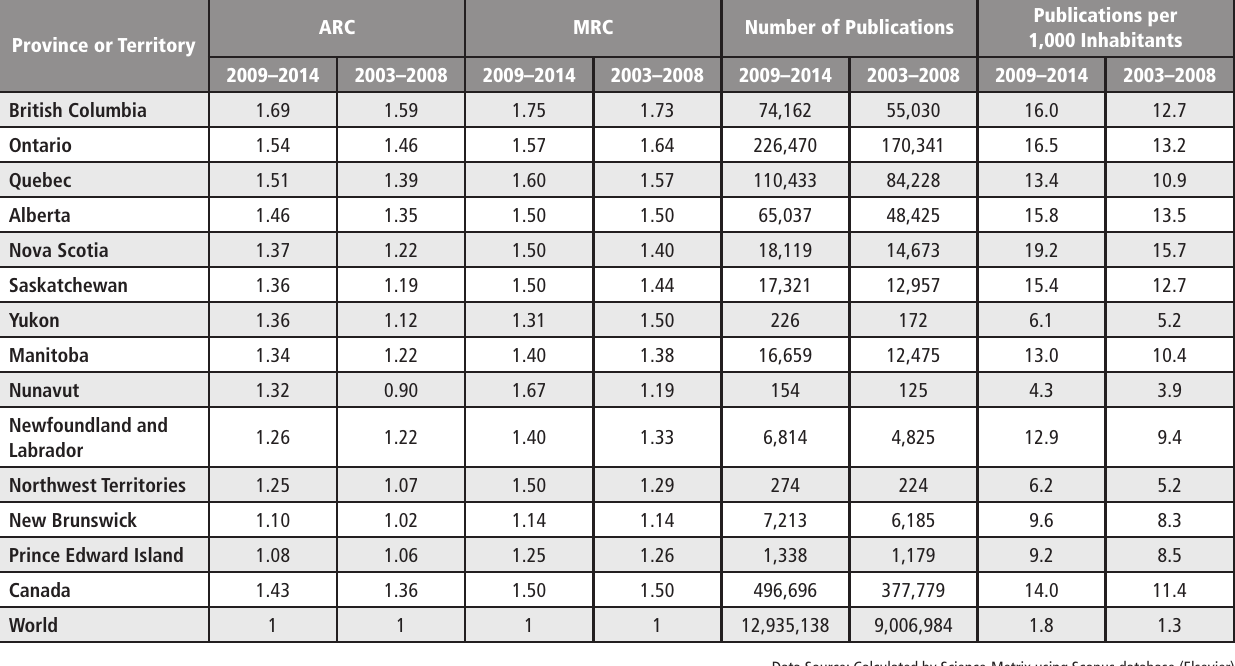
Number of Publications, Average Relative Citation, Median Relative Citation, and Number of Publications per 1,000 Inhabitants